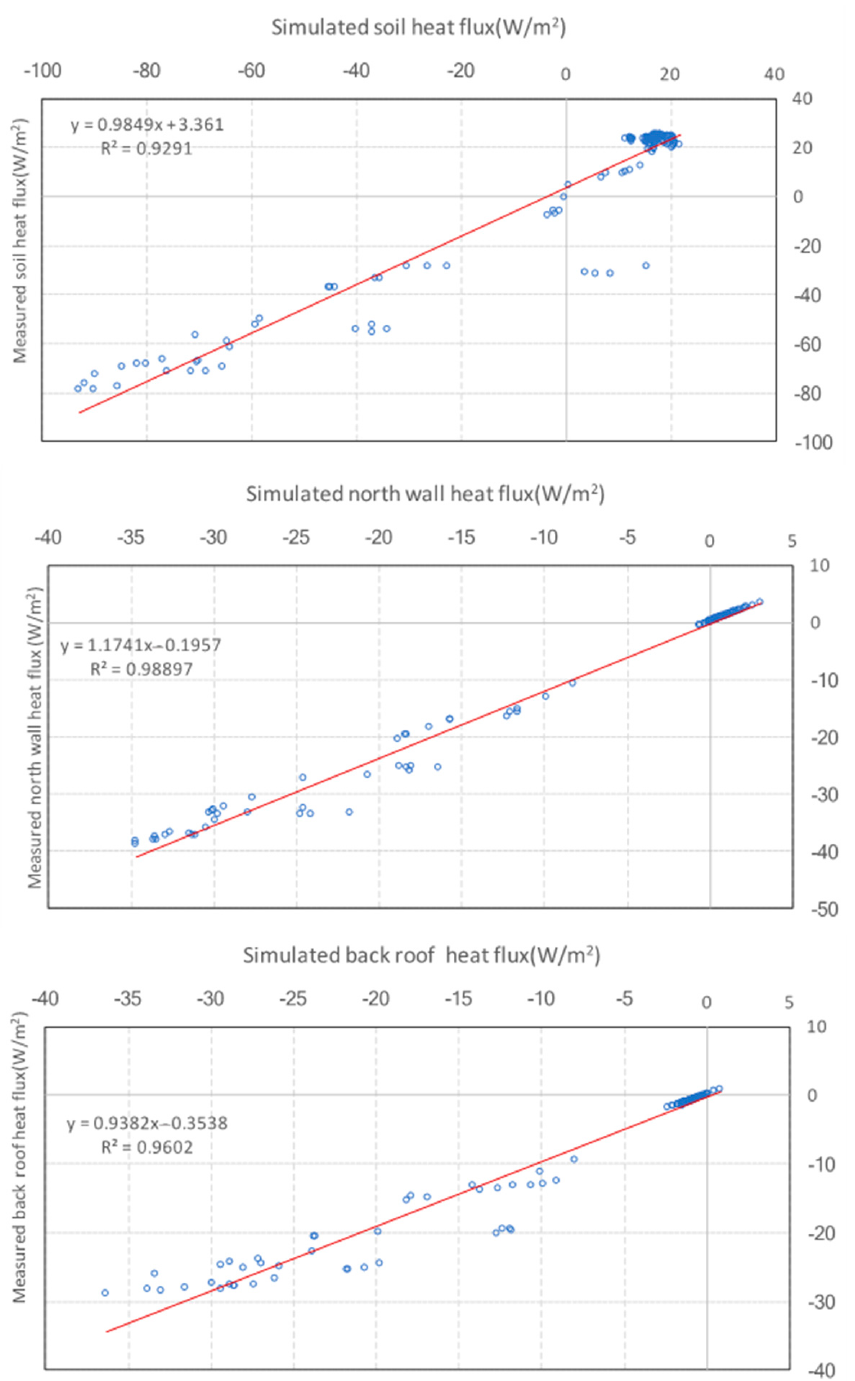
Figure 18. Relationship between simulated and measured heat flux variations during clear days.